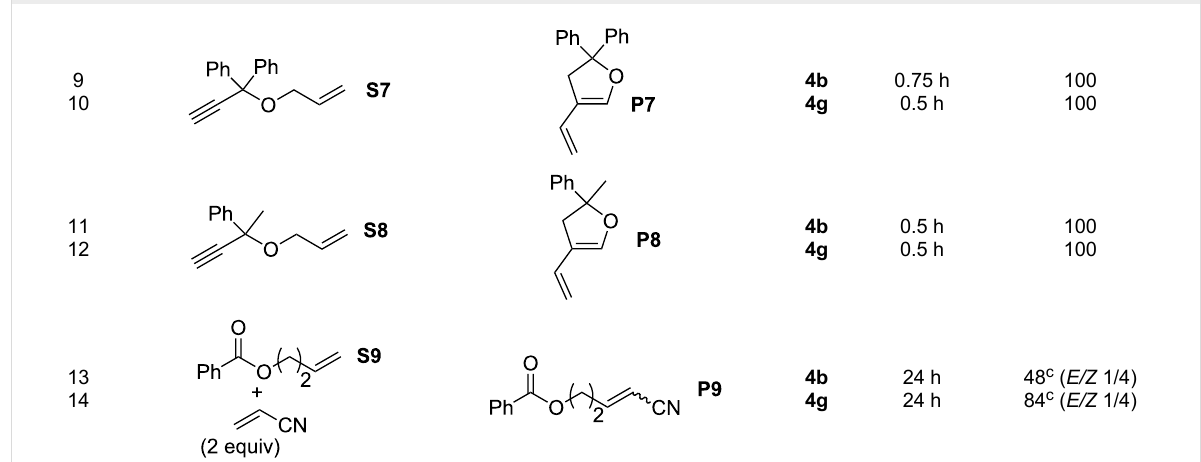
Table 2: Comparison of 4b and 4g in metathesis reactions a .